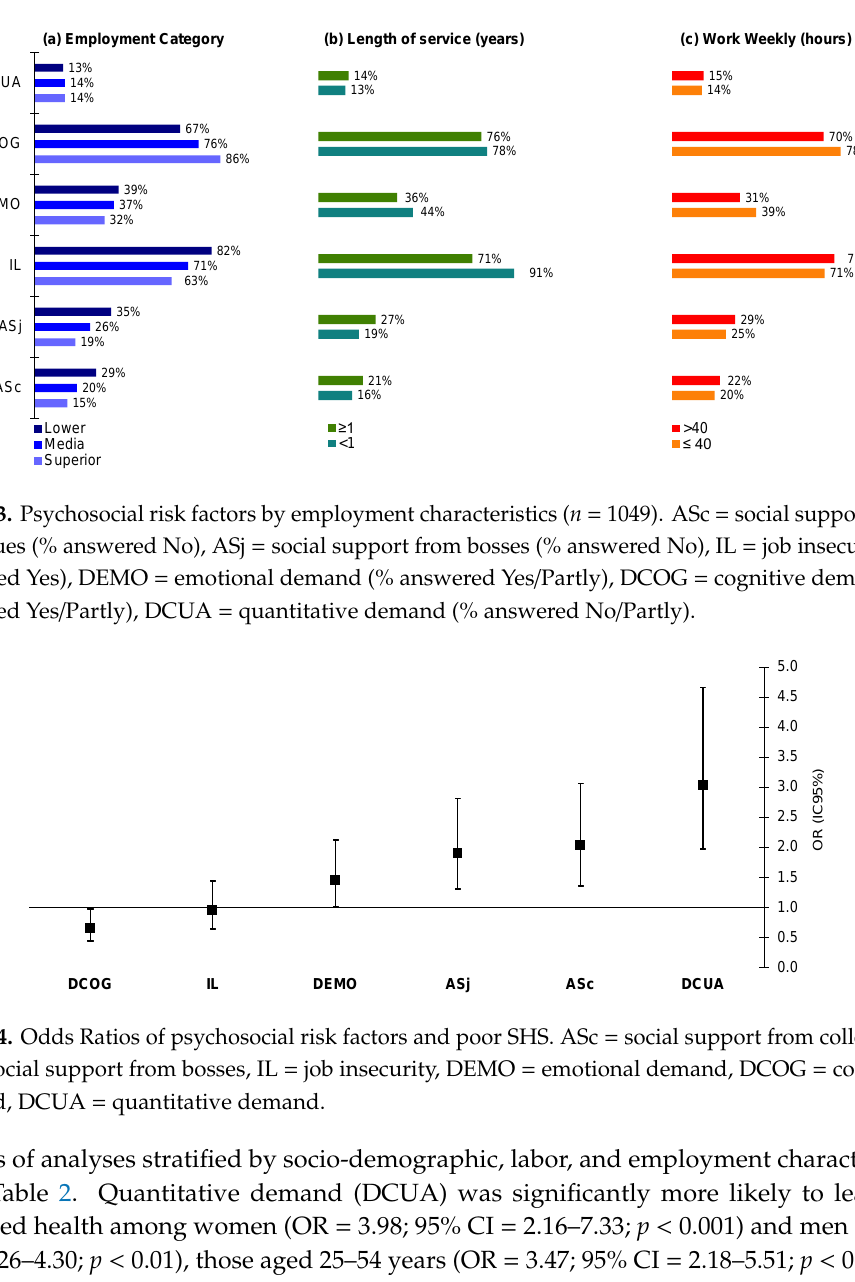
Figure 4. Odds Ratios of psychosocial risk factors and poor SHS. ASc = social support from colleagues, ASj = social support from bosses, IL = job insecurity, DEMO = emotional demand, DCOG = cognitive demand, DCUA = quantitative demand.